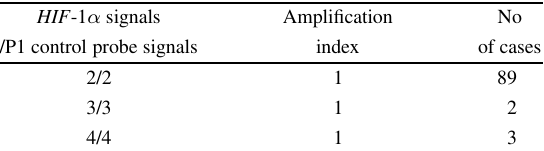
Gene copy amplification analysis for HIF -1 α by